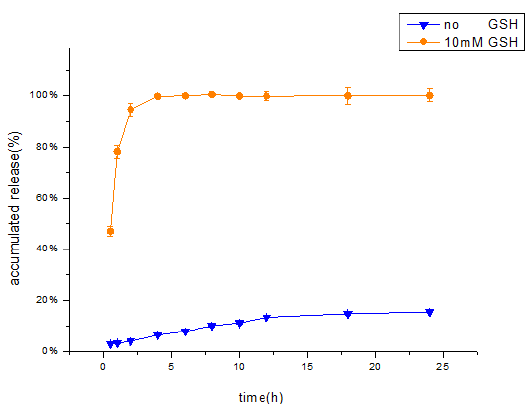
Figure 7. In Vitro cumulative percentage release of MP from HA-DOP-Cu-MP nanoparticles in pH 7.4 Figure 7. In vitro cumulative percentage release of MP from HA-DOP-Cu-MP nanoparticles in pH 7.4 Figure 7. In vitro cumulative percentage release of MP from HA-DOP-Cu-MP nanoparticles in pH 7.4 Figure 7. In vitro cumulative percentage release of MP from HA-DOP-Cu-MP nanoparticles in pH 7.4 phosphate bu ff er solution ( 10 mM GSH). The dialysis bag method was used to phosphate buffer solution ( no GSH, 10 mM GSH). The dialysis bag method was used to phosphate buffer solution ( no GSH, 10 mM GSH). The dialysis bag method was used to phosphate buffer solution ( no GSH, 10 mM GSH). The dialysis bag method was used to conduct the release study at 37 ◦ C in a shaker bath (50 rpm). conduct the release study at 37 °C in a shaker bath (50 rpm). conduct the release study at 37 °C in a shaker bath (50 rpm). conduct the release study at 37 °C in a shaker bath (50 rpm). Table 2. Correlation coe ffi cient obtained by fitting the data for the release of MP from HA-DOP-Cu-MP Table 2. Correlation coefficient obtained by fitting the data for the release of MP from HA-DOP-Cu- Table 2. Correlation coefficient obtained by fitting the data for the release of MP from HA-DOP-Cu- Table 2. Correlation coefficient obtained by fitting the data for the release of MP from HA-DOP-Cu- into a bu ff ered solution at pH 7.4 (with or without 10 mM glutathione MP into a buffered solution at pH 7.4 (with or without 10 mM glutathione (GSH)). MP into a buffered solution at pH 7.4 (with or without 10 mM glutathione (GSH)). MP into a buffered solution at pH 7.4 (with or without 10 mM glutathione (GSH)).